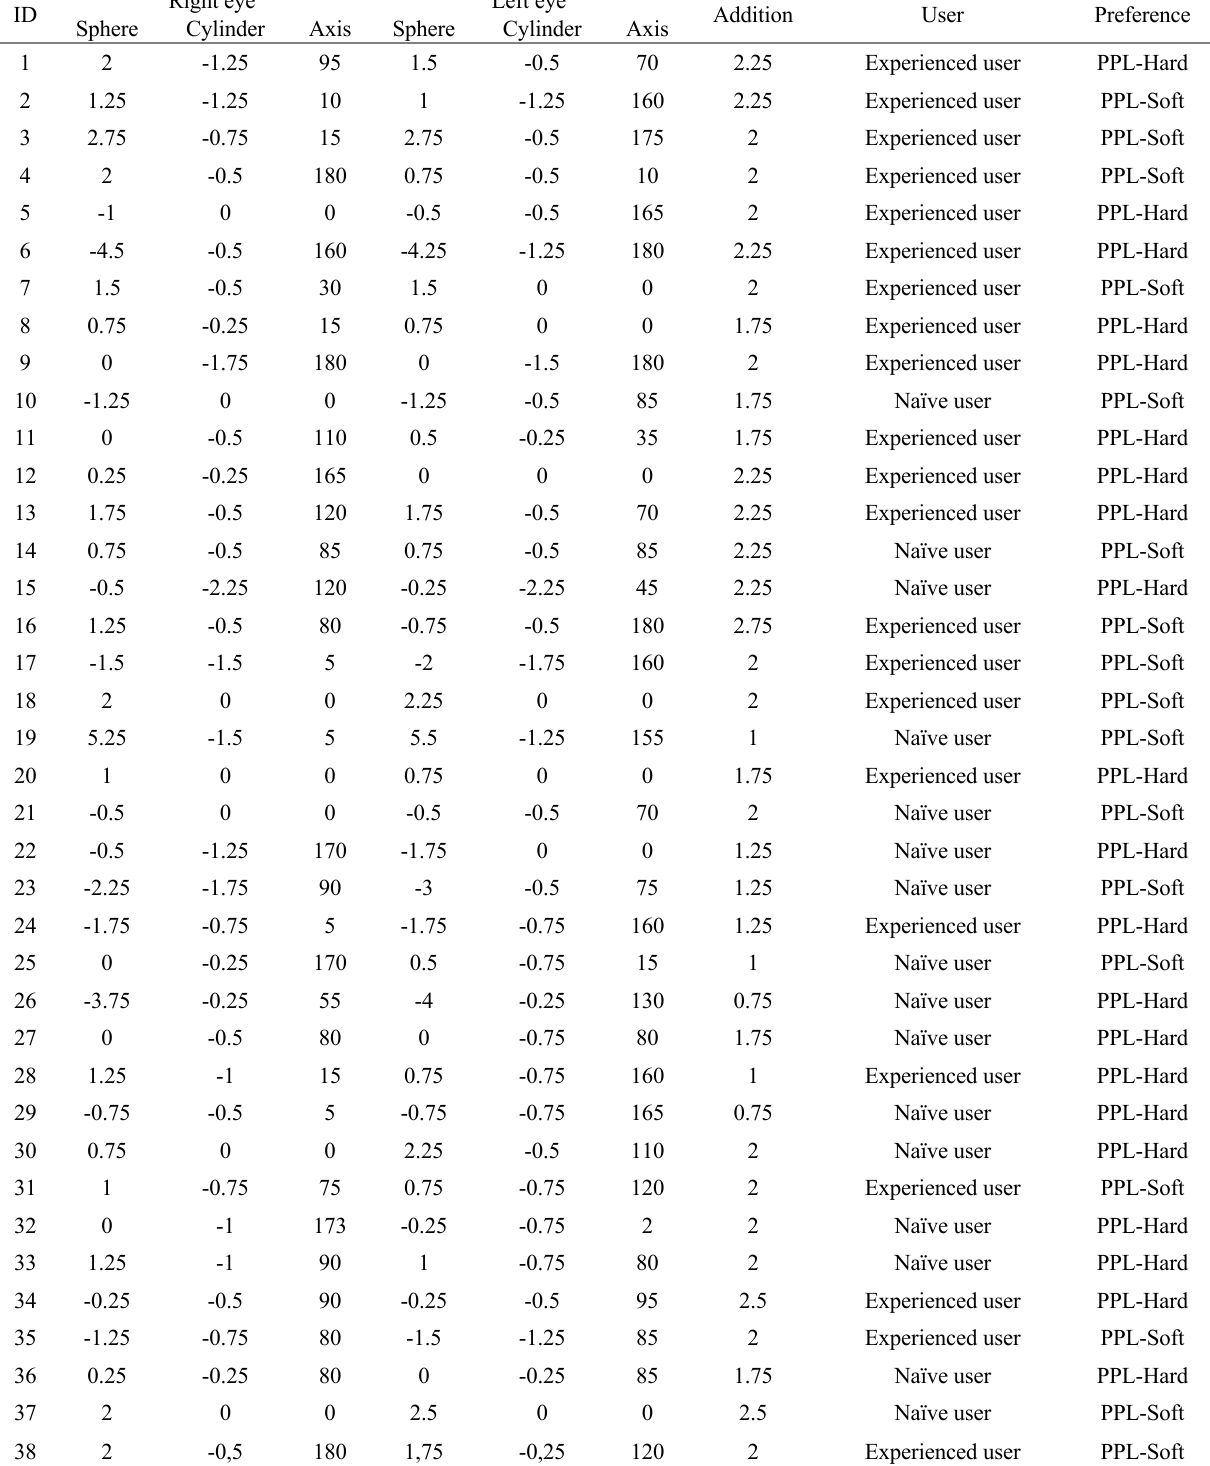
Table 1. Refractive error, addition, type of user and preference distribution for each